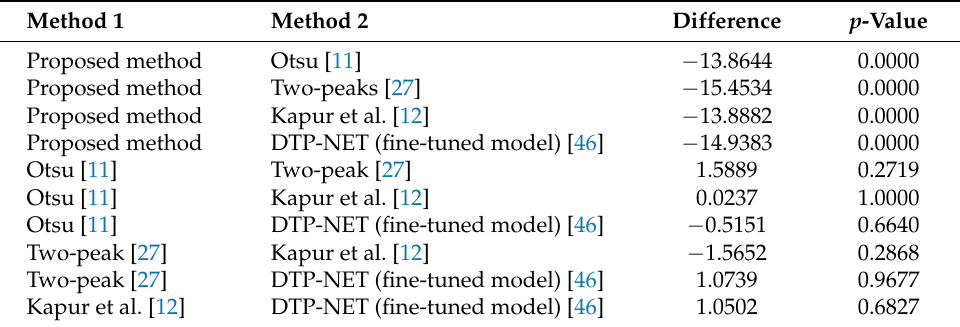
Table A3. Results of multiple comparisons test: pair-wise comparison of different methods based on the PSNR scores. The third column (Difference) indicates the difference between the means of Method 1 and Method 2. The fourth column ( p -value) indicates the probability of the means of Method 1 and Method 2 being equal.